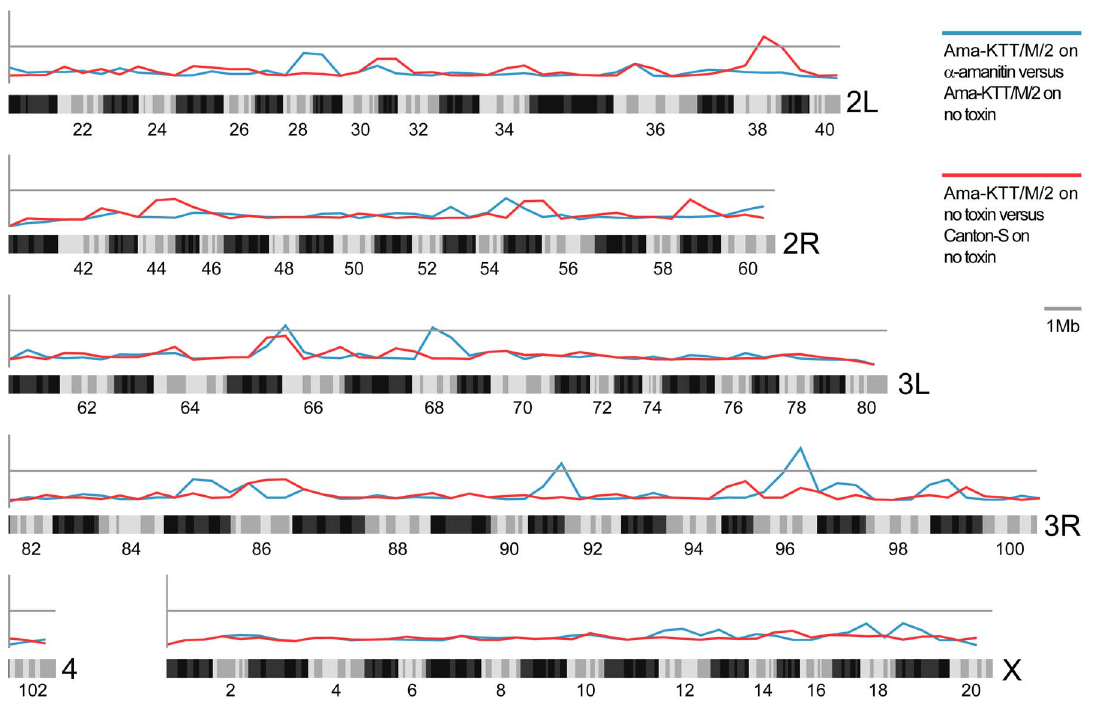
Figure 3. Genome enrichment analysis for genomic correlates. Genomic correlates are likely disrupted in Ama-KTT/M/2 versus Canton S (red) and Ama-KTT/M/2 on a -amanitin versus Ama-KTT on non-toxic food (blue). Colored lines above the gray line indicate significant enrichment of a genomic correlate. Of the five genomic correlates rising above the cutoff value, two genomic correlates are similar to those found in previous linkage studies on the Ama-KTT stock.